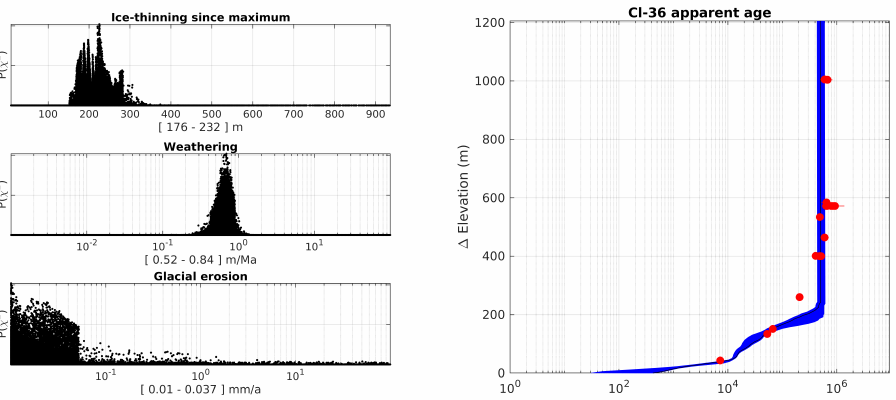
Figure 4. Marble Hills NUNAIT results. Results of fitting the NUNAIT model to Marble Hills’ data. Right graph: data are depicted in red, and the models fitting the data within 1 σ confidence level are plotted in blue. The best-fitting model, with a reduced chi-squared value of 7.2, is shown as a black line. Left graphs: probability distribution of the tested parameters.